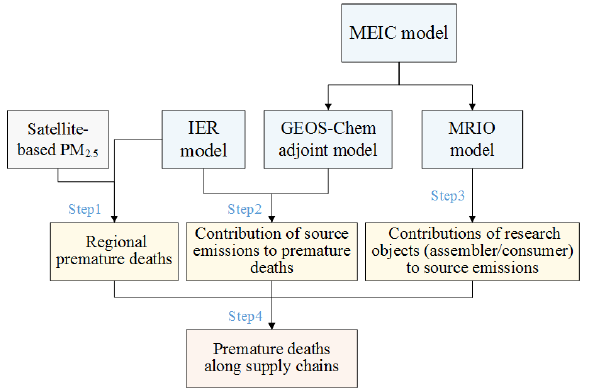
Figure 1. Schematic of the methodology used in this